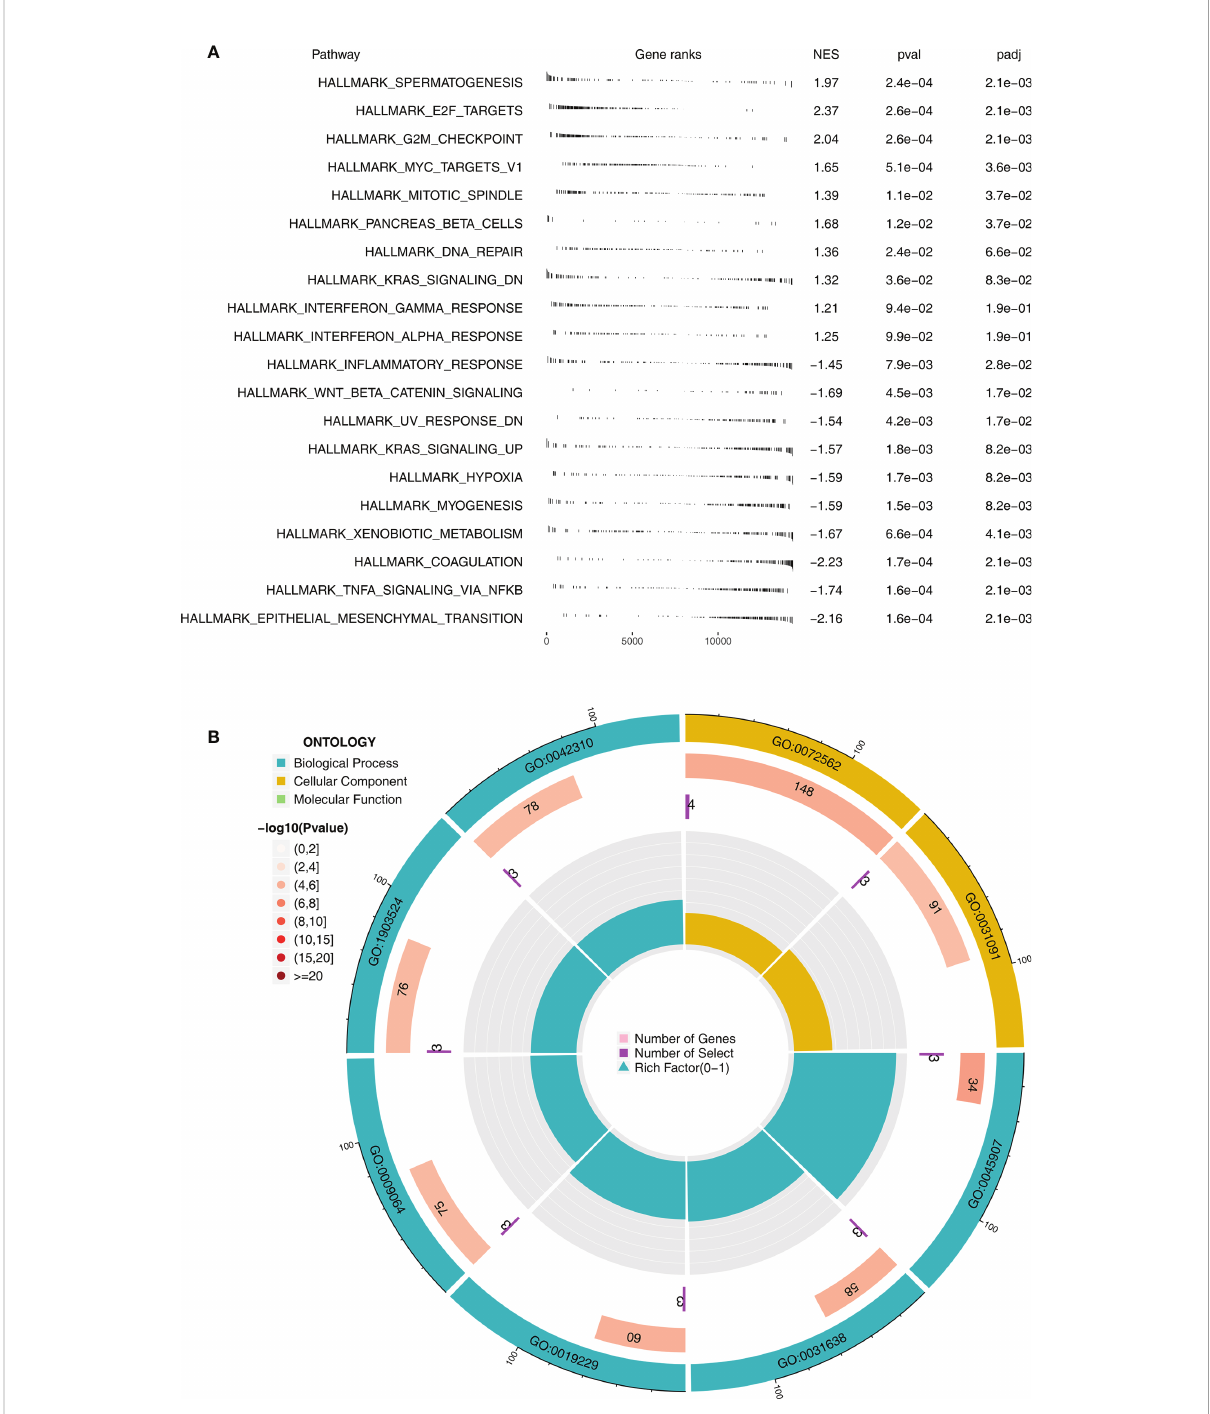
FIGURE 2 Biological enrichment between immunotherapy responders and non-responders (A) GSEA between immunotherapy responders and non- responders based on the Hallmark gene set. (B) GO analysis using the clusterpro fi ler